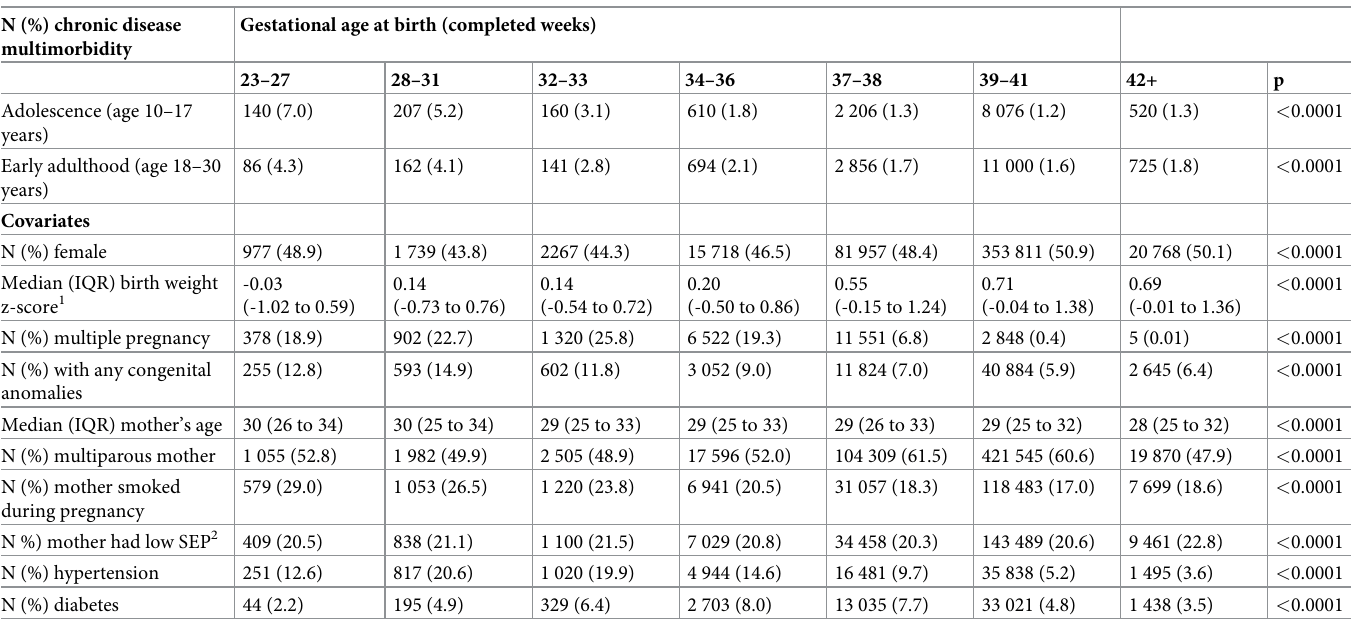
Table 1. Characteristics of study